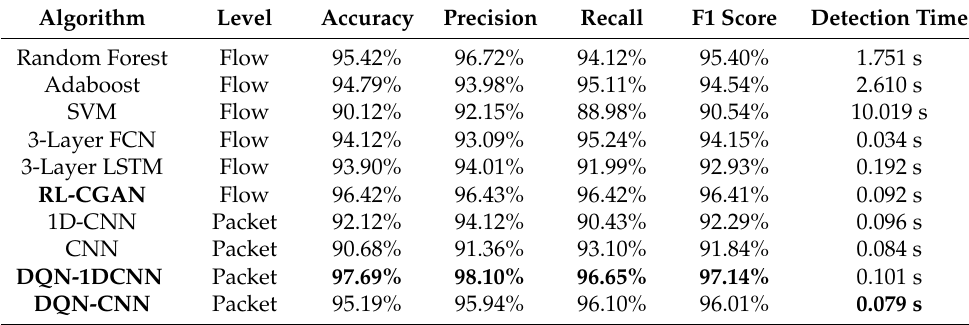
Table 17. Comparison with different